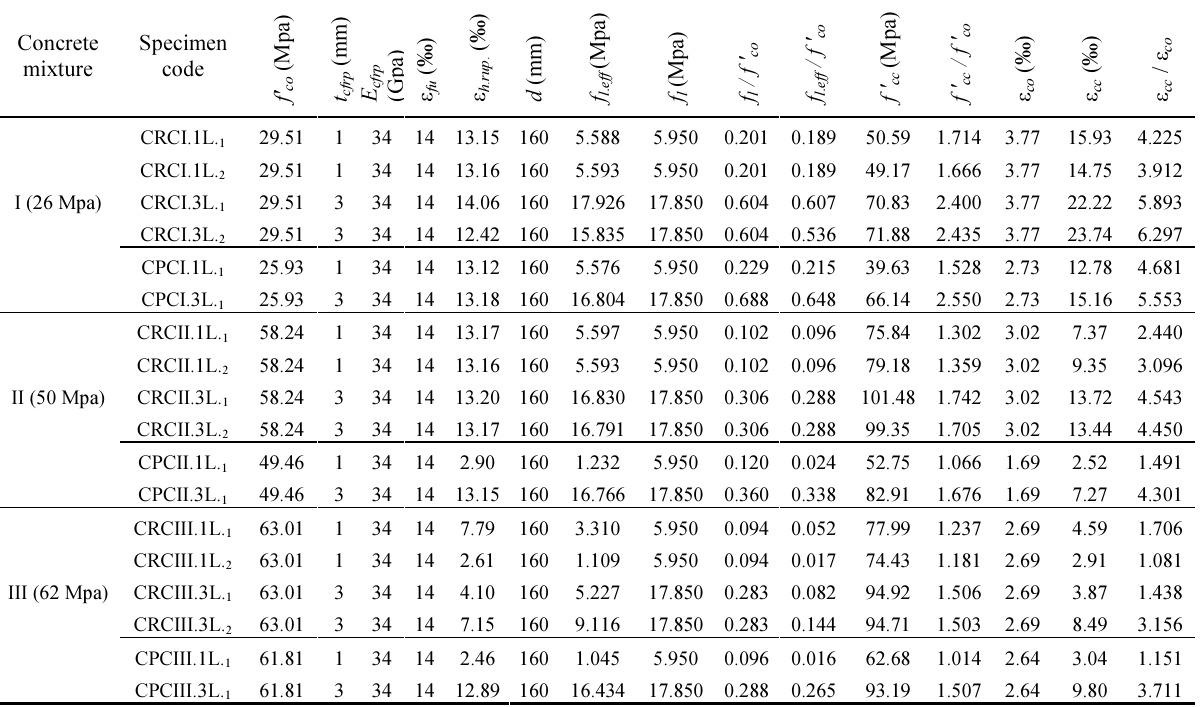
Table 5. Data and results of CFRP wrapped cylinders Concrete mixture